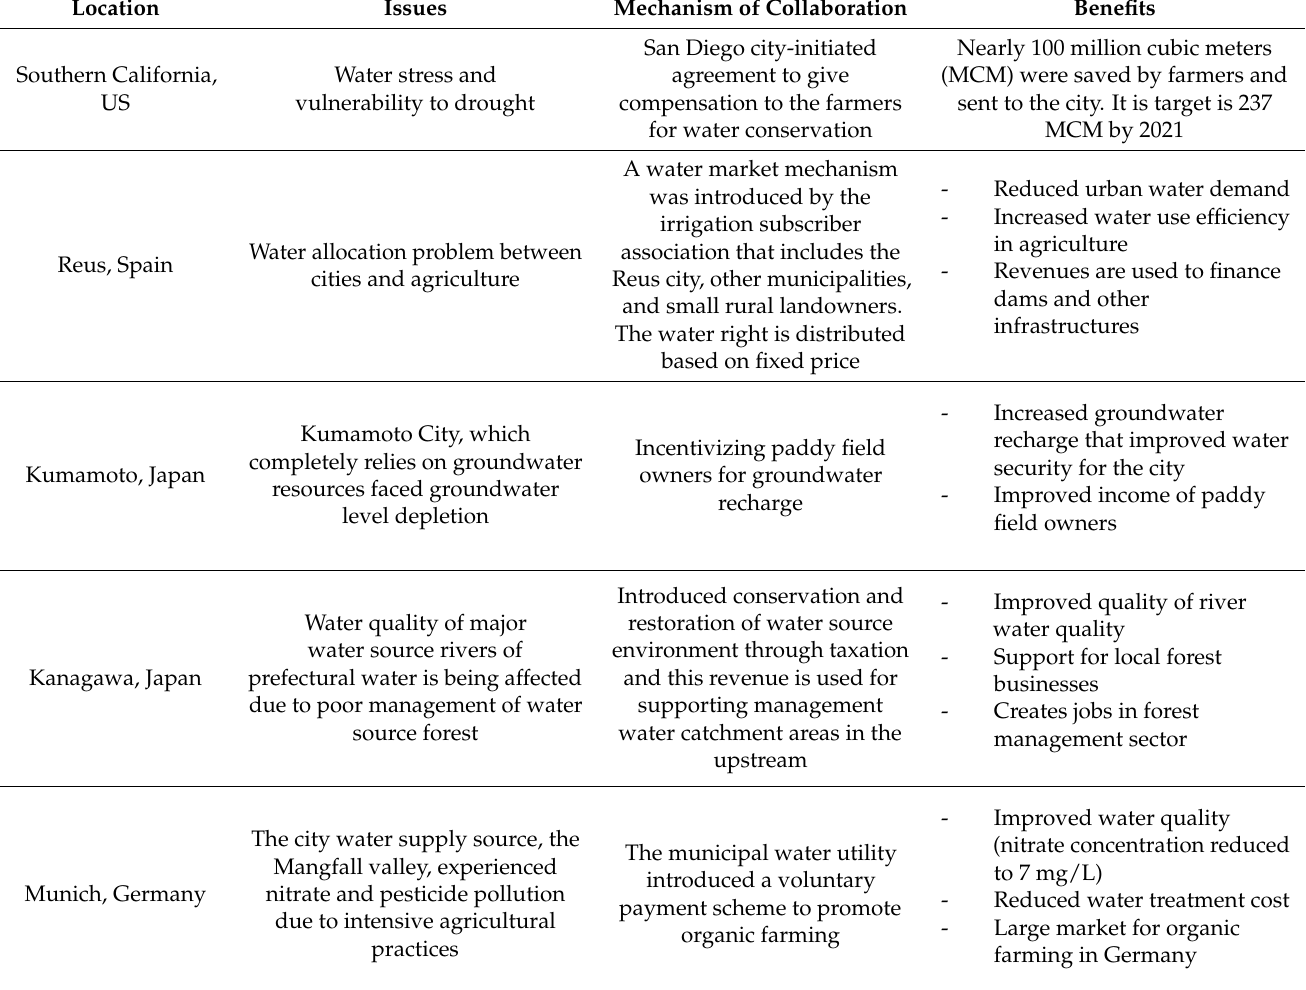
Table 3. Urban–rural cooperation for water management and water